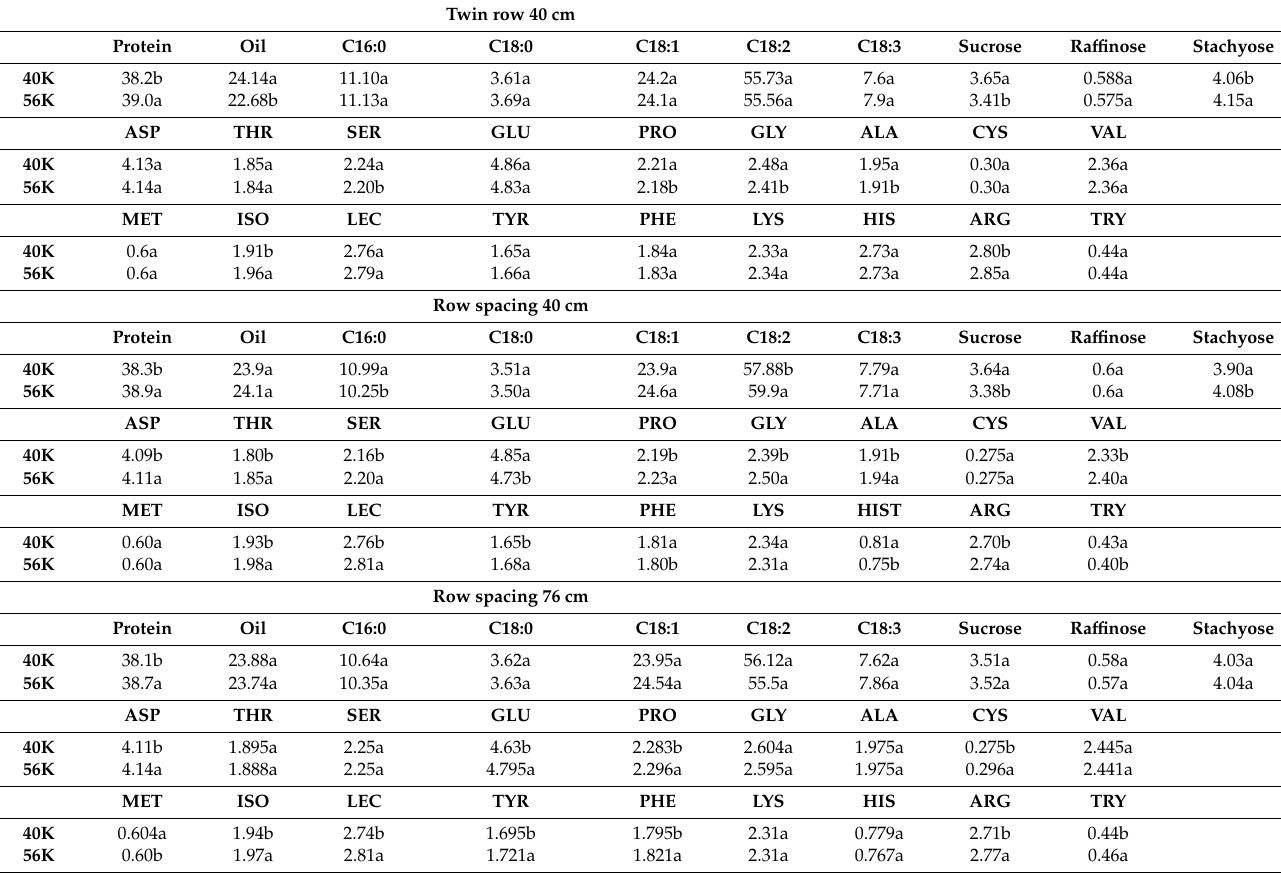
Table 8. The e ff ect of seeding rate and row spacing (15 inches twin row, 15 row spacing, and 30 row spacing (40 cm and 76 cm, respectively) on seed composition (protein; oil, palmitic (C16:0), stearic (C18:0), oleic (C18:1), linoleic (C18:2), linolenic (C18:3); sugars (sucrose, ra ffi nose, stachyose) (%); and amino acids aspartic acid (ASP), threonine (THR), serine (SER), and glutamic acid (GLU), proline (PRO), glycine (GLY), alanine (ALA), cystine (CYS), valine (VAL), methionine (MET), iso-leucine (ISO), leucine (LEU), tyrosine (TYR), phenylalanine (PHE), lysine (LYC), histidine (HIS), arginine (ARG), and tryptophan (TRY) (%) in cultivar P 47T36R, in 2016. Twin row 40 cm Protein Oil